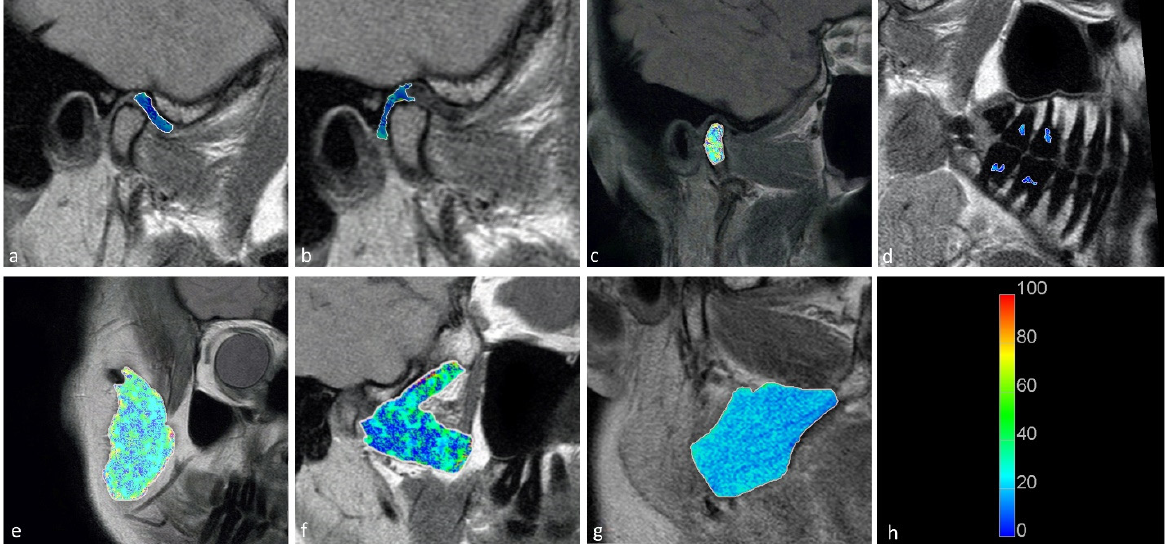
Figure 2. Short T2 maps obtained for the ( a ) disk; ( b ) retrodiscal tissue; ( c ) bone marrow of the condyloid process; ( d ) pulp; ( e ) m. masseter; ( f ) m. pterygoideus lateralis; and ( g ) m. pterygoideus medialis. ( h ) Color scale showing the reference T2 times in seconds.